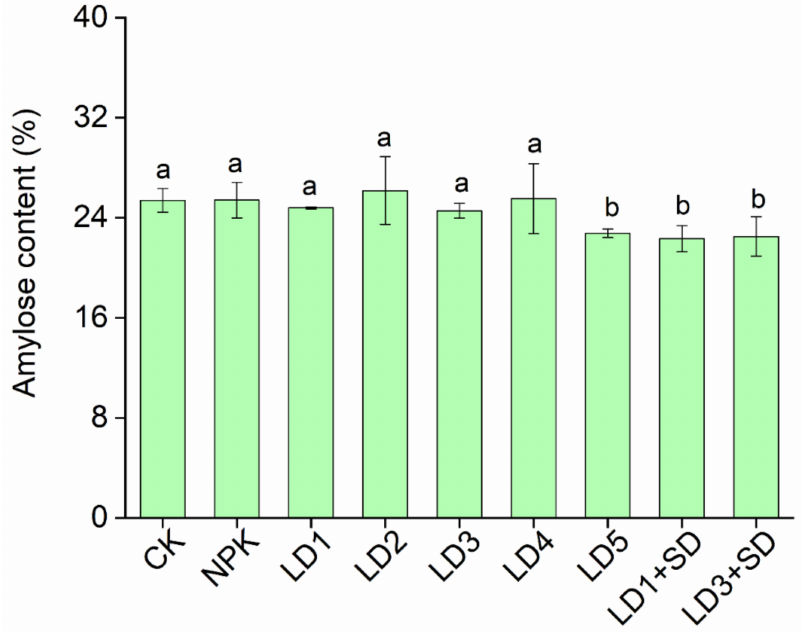
Figure 6. The amylose content of rice grains under different treatments, respectively. The values are means with standard error bars. Different letters above the bars indicate significant differences at the 5%